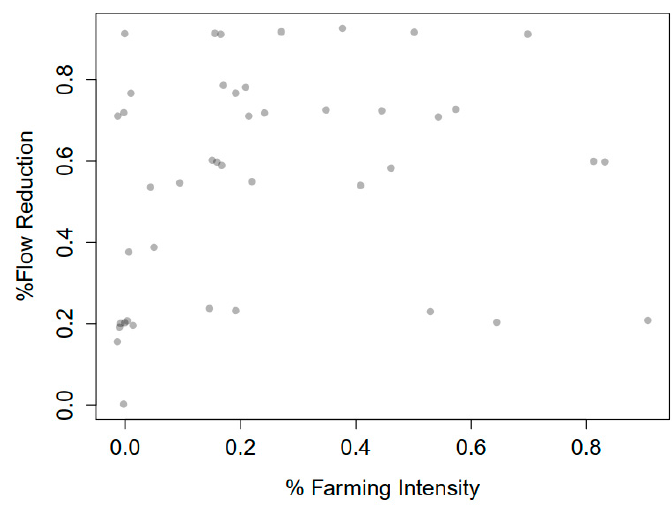
Figure 2. Distribution of the 43 stream sites along the gradients of % Farming Intensity and % Flow Flow Reduction.